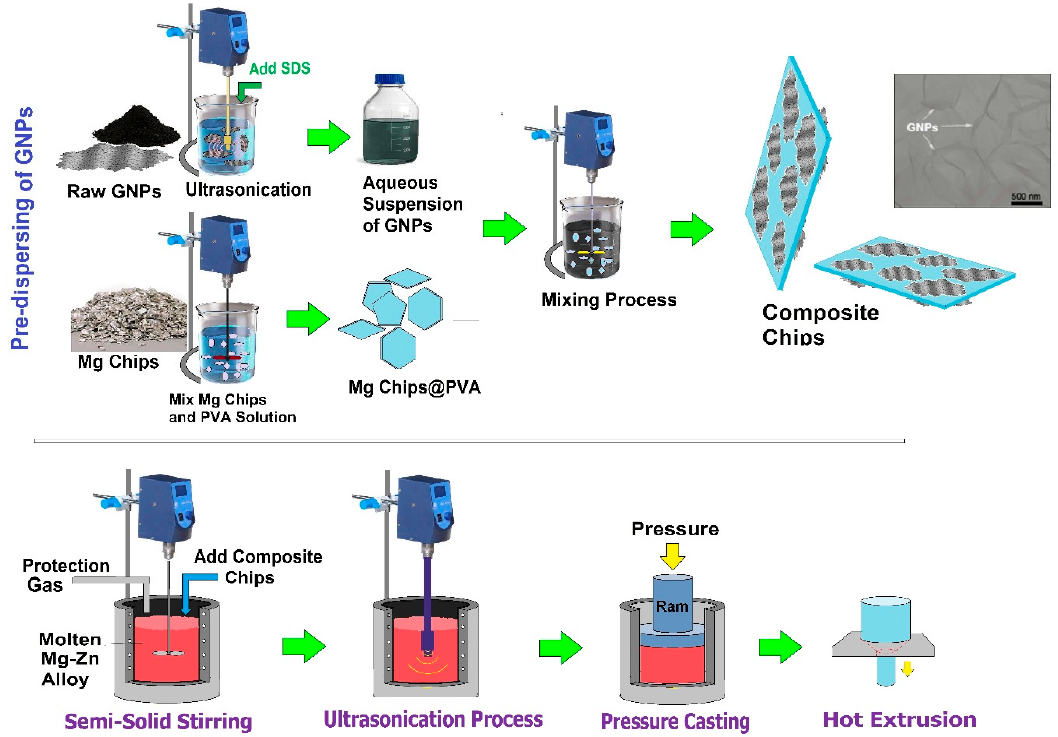
Figure 10. Fabrication route of the Mg-based composite encapsulated within GNPs using the multi-step dispersion route (MSDR) reproduced or adapted from [83], with permission from nature research, 2016.